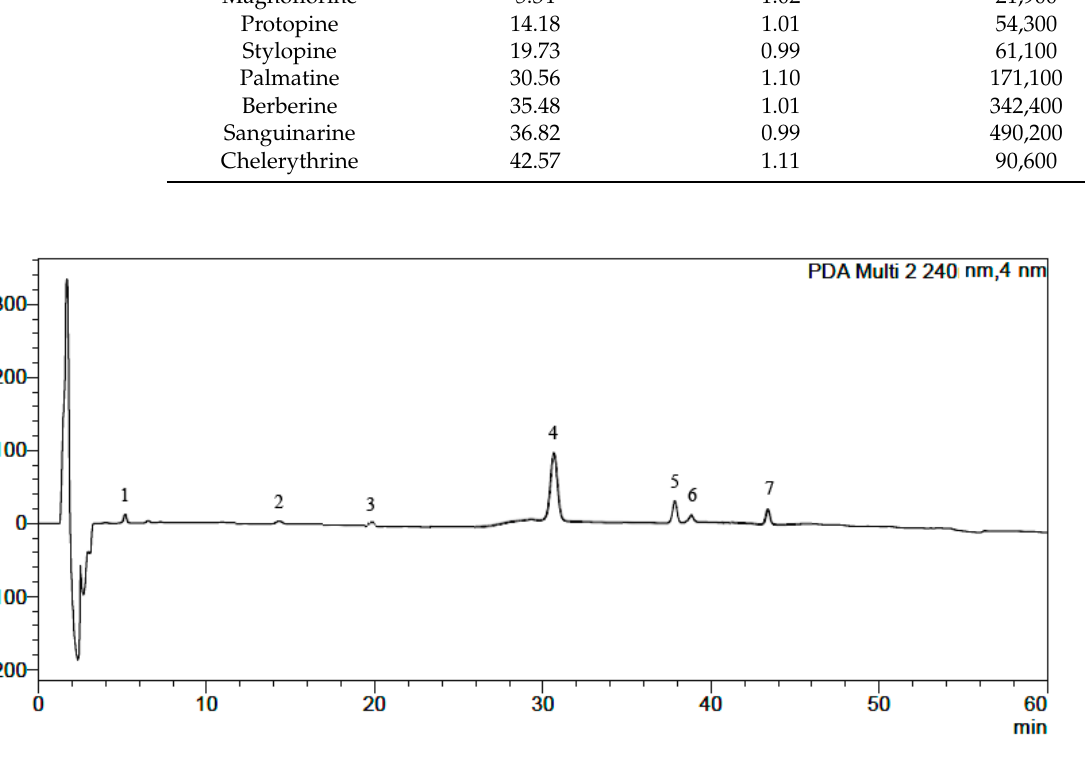
Figure 1. HPLC-DAD chromatogram obtained for mixture of alkaloid standards: 1—magnoflorine, 2—protopine, 3—stylopine, 4—palmatine, 5—berberine, 6—sanguinarine, 7—chelerythrine.